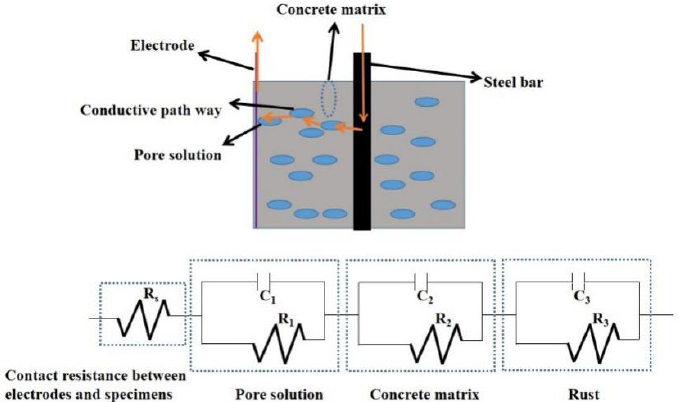
Figure 10. Corresponding equivalent circuits of reinforced alkali-activated mineral admixtures. Table 5. The fitting results of the equivalent circuit diagram. Specimens Chi-Square